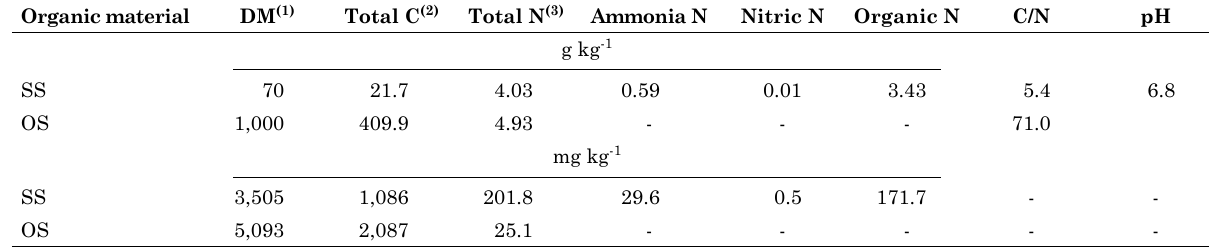
Table 1. Dry matter (DM), total carbon (C) and nitrogen (N) concentration and quantities added to soil by sewage sludge (SS) and oat straw (OS) Organic